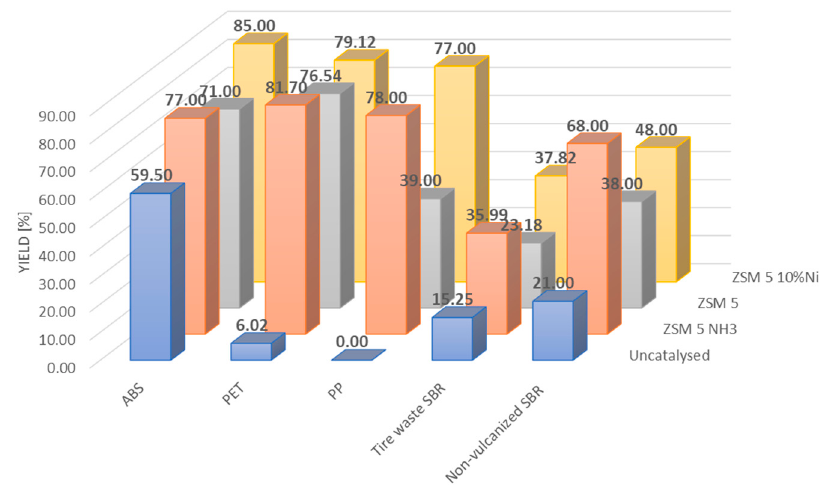
Figure 5. All aromatics yield as a function of material and catalyst ratio (based on [19]).